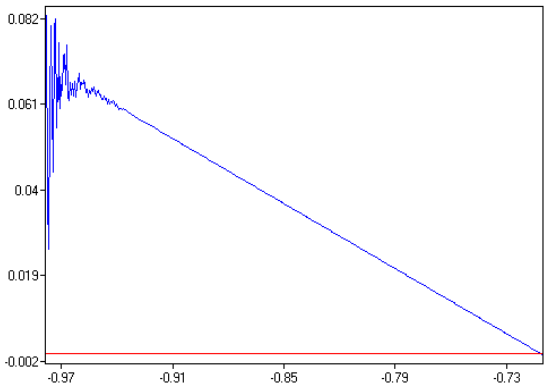
Figure 4. Maximum Lyapunov exponent for adaptive expectations and 𝛾 = (−0.978;−0.711) .